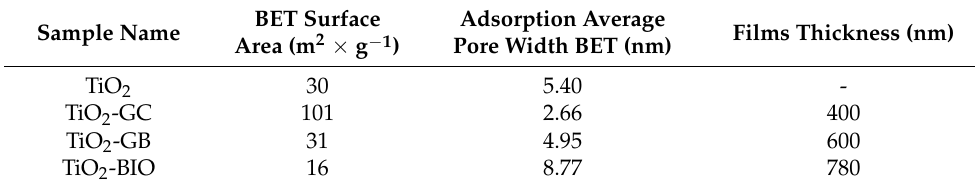
Figure 3. BET results with p/p ◦ being the ratio of the applied N 2 pressure over the N 2 relative vapor pressure. ( a ) Isotherm of TiO 2 and TiO 2 -BIO; ( b ) Isotherm of TiO 2 -GB; ( c ) Isotherm of TiO 2 -GC; and ( d ) BJH pore diameter desorption of TiO 2 -GC (dV/dlog(D)) in ordinate represents the ratio of the derivative of the absorbed volume and the derivative of the log of the pore diameter). Table 2. BET results and thicknesses from SEM cross-section